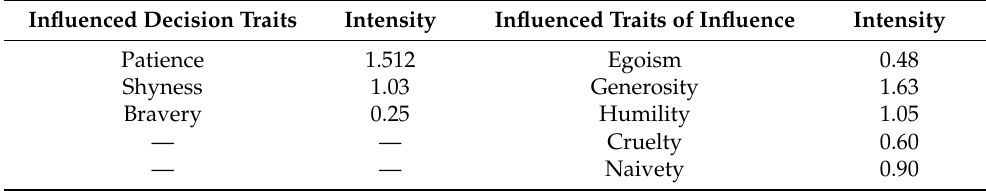
Table 9. Results of the influence calculation of the decision and influence traits. Influenced Decision Traits